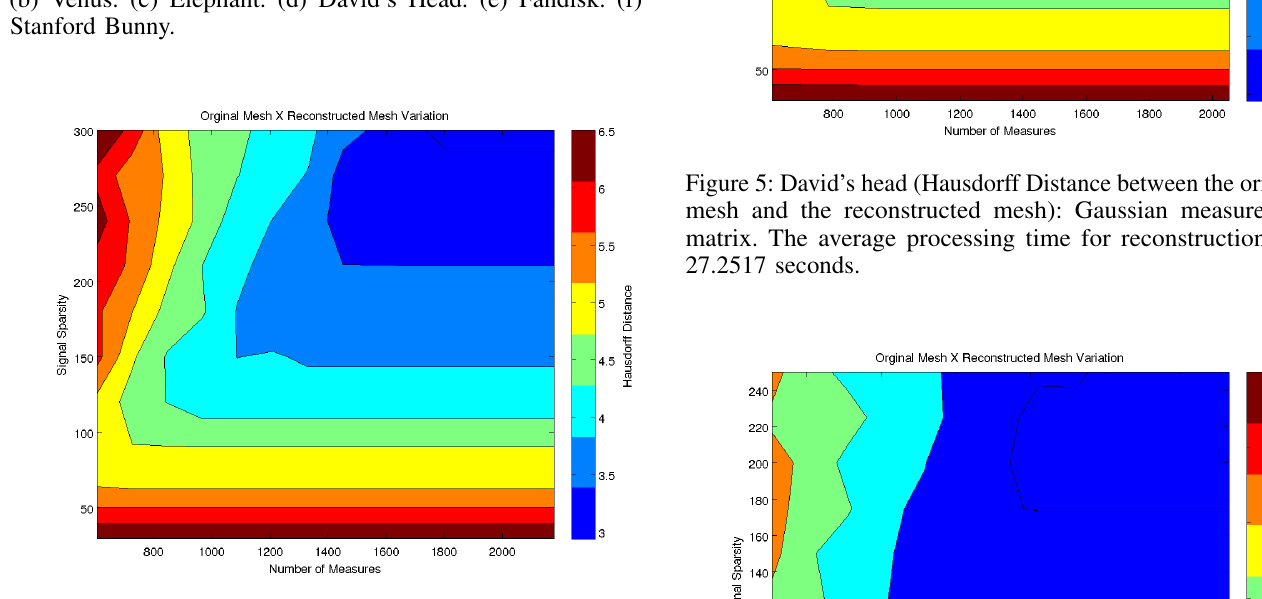
Figure 4: David’s head (Hausdorff Distance between the original mesh and the reconstructed mesh): Noiselet measurement matrix. The average processing time for reconstruction was 35.2912 seconds.